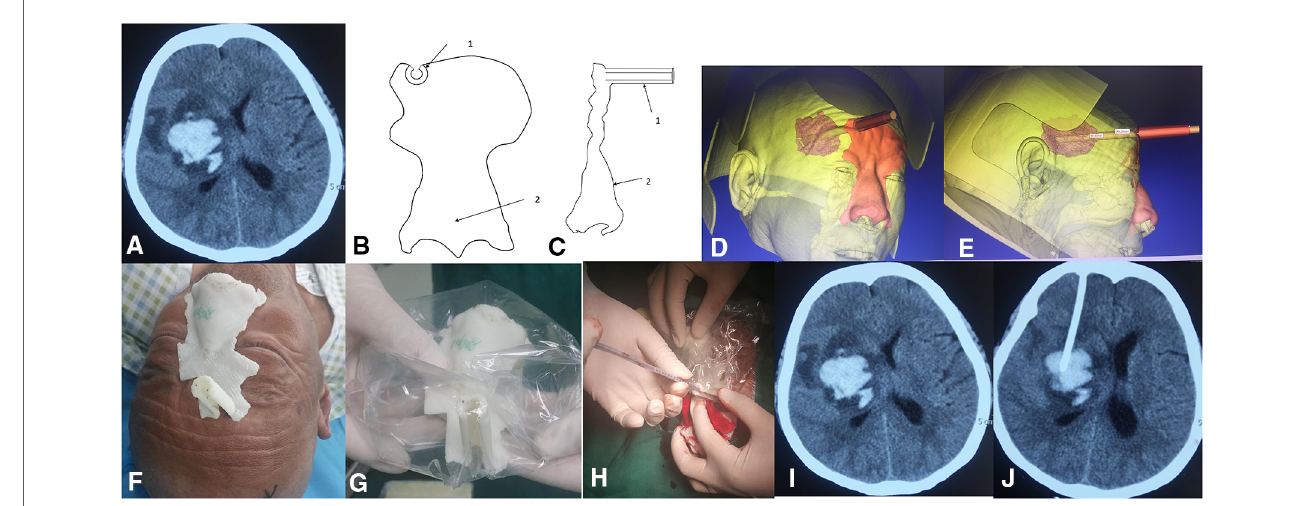
FIGURE 2 The 3D printing model guides the surgical method for hematoma puncture